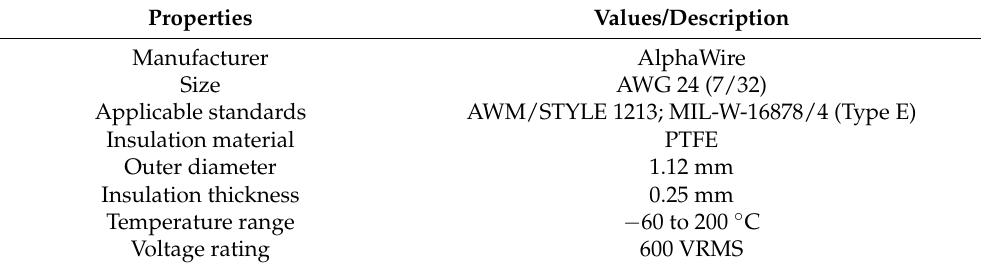
Table 2. Properties of the analyzed PTFE-insulated wires.